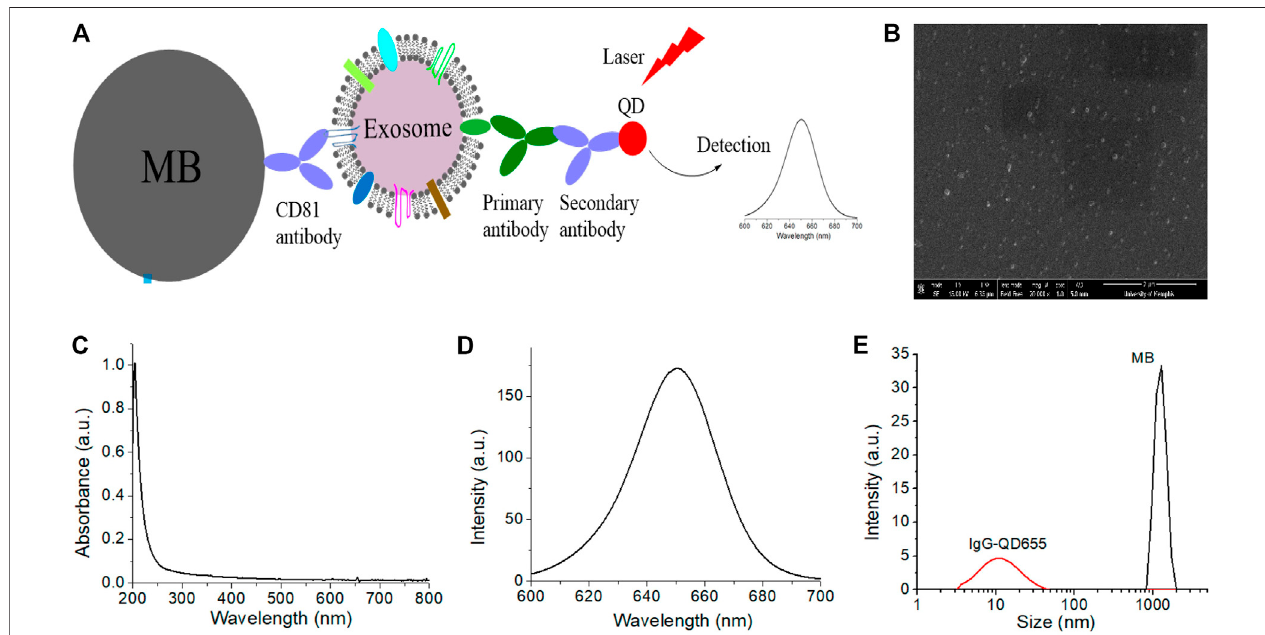
FIGURE 7 | Schematic representation of the (A) QD-based EXO assay, (B) characterization of EXOs via SEM image of plasma from a BC patient, and characterization of QDs (C – E) via (C) absorption spectrum (D) emission spectrum of IgG-QD655 and (E) DLS characterization of the hydrodynamic size of